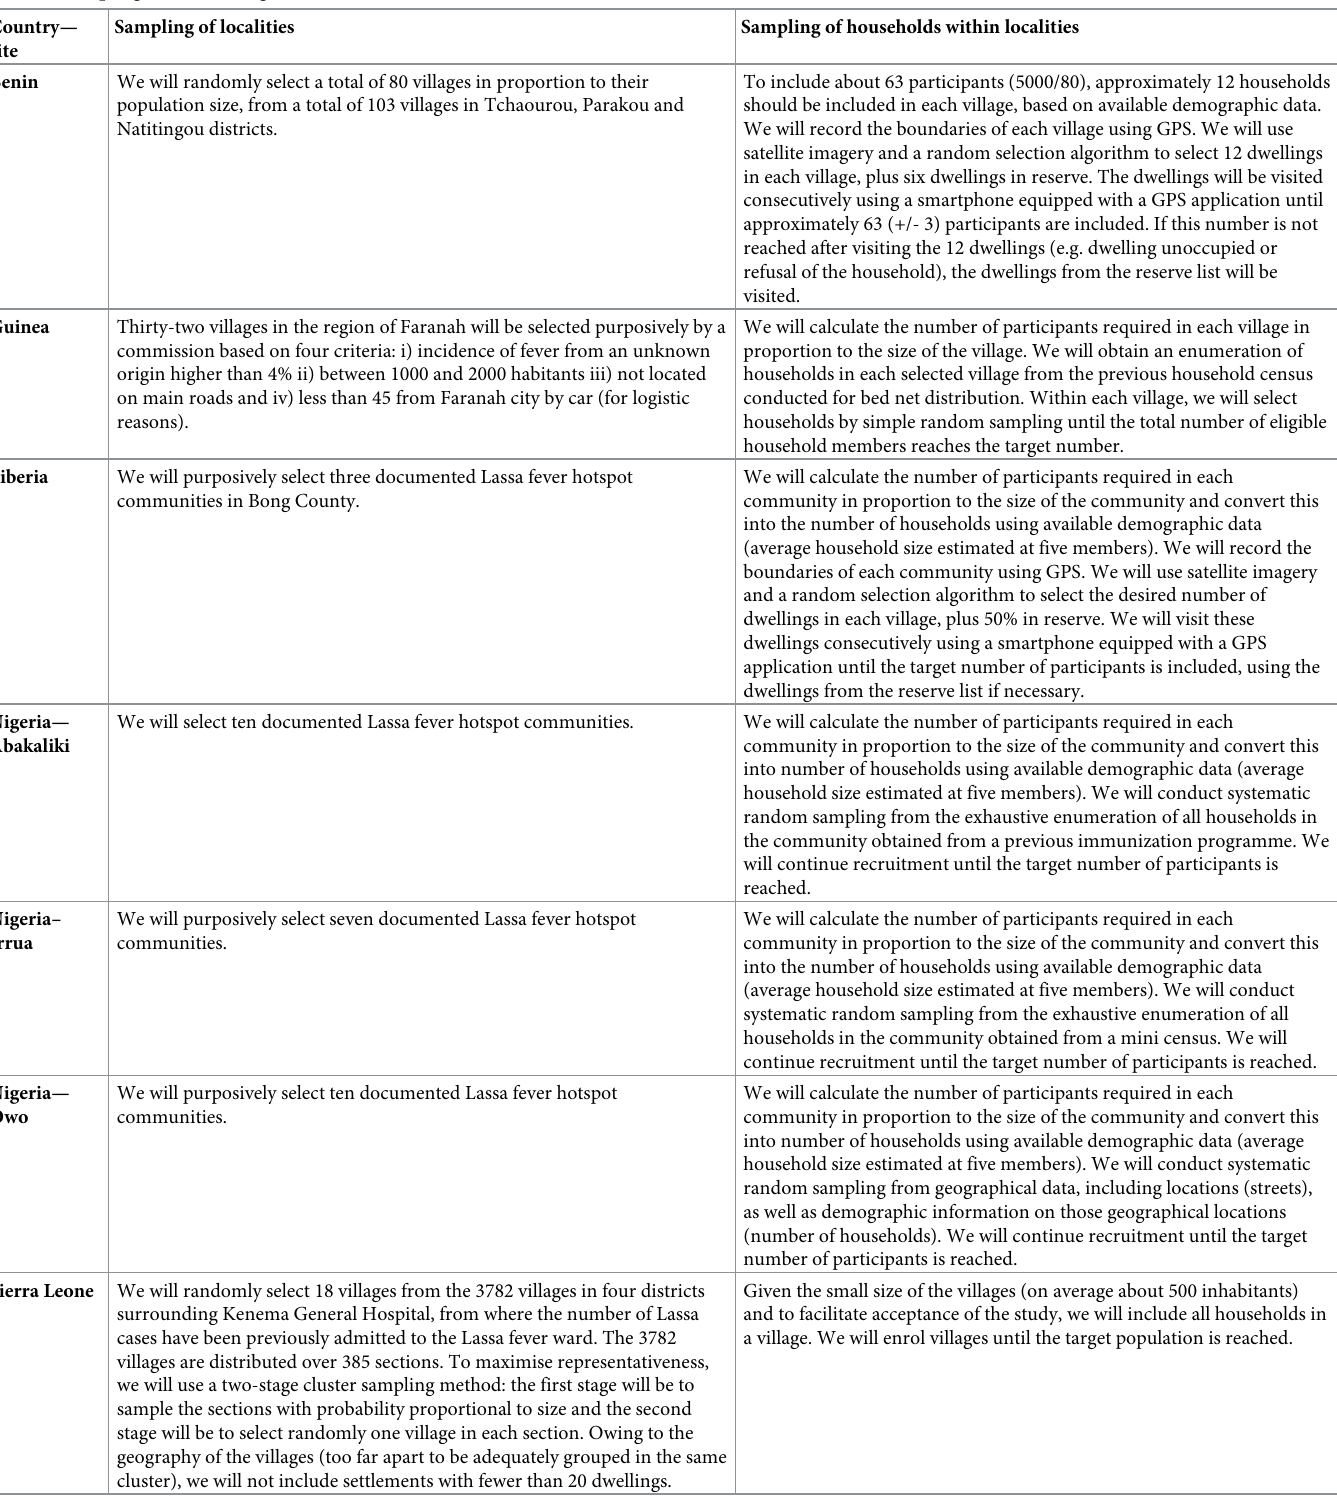
Table 5. Sampling methods being used in each site. Country—